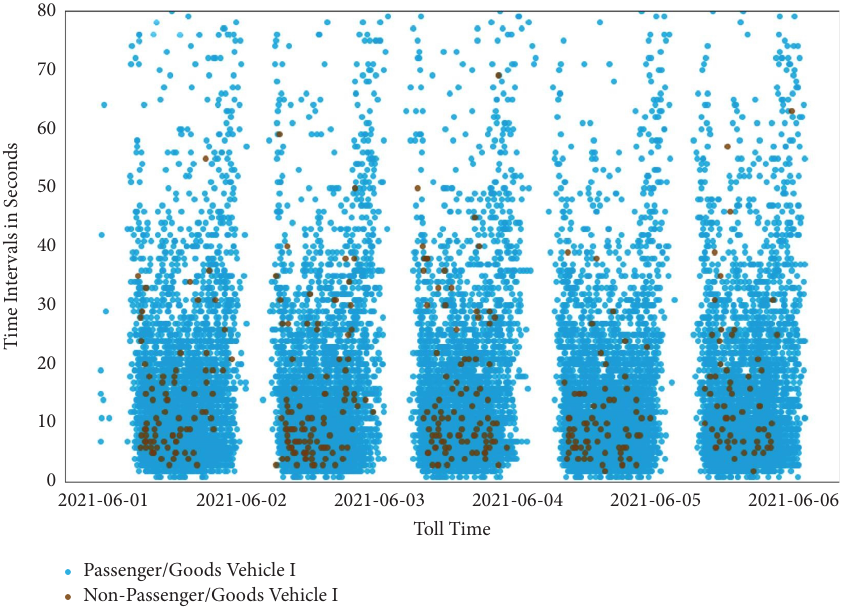
Figure 2: Scattergrams of time intervals of ETC entrance lane 1# at No. 6706 toll station.